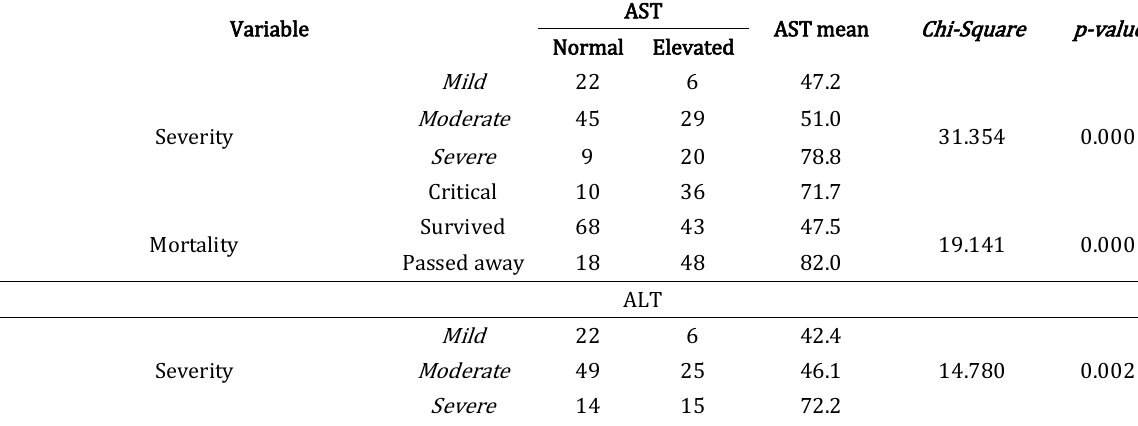
Table 3. Transaminase data in COVID-19